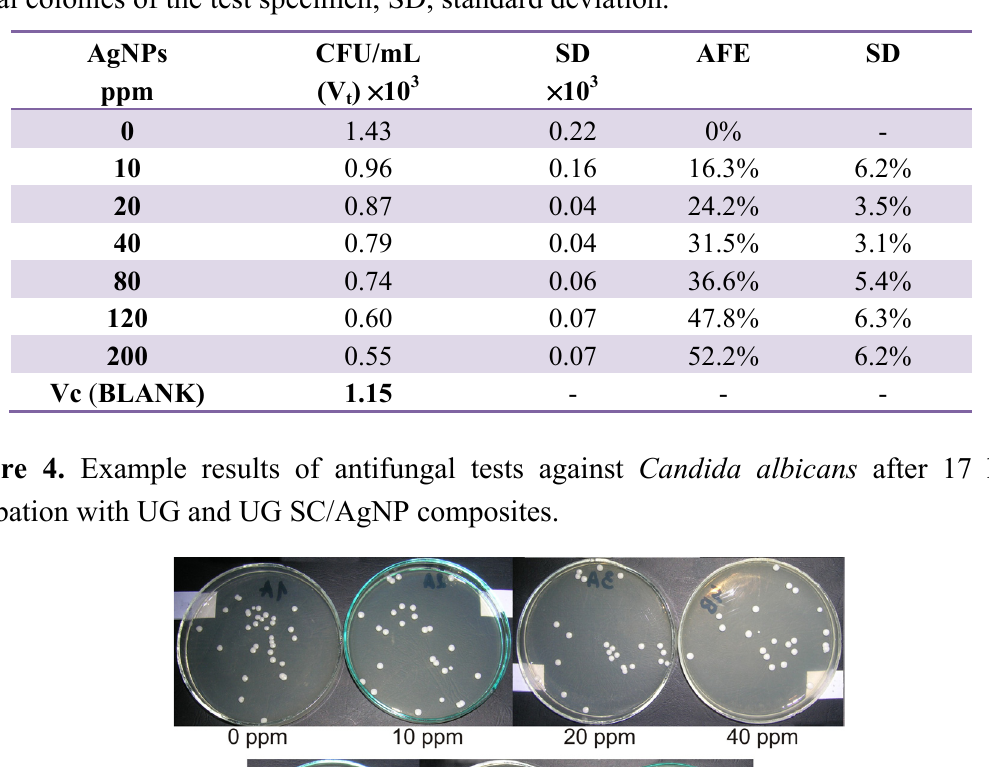
, the number of viable t